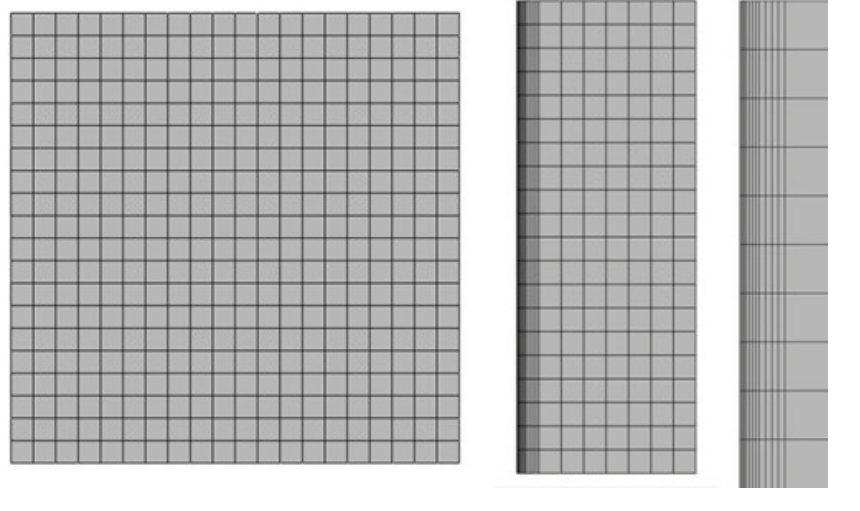
Figure 2. The top view, right view and partial enlarged view of the computational